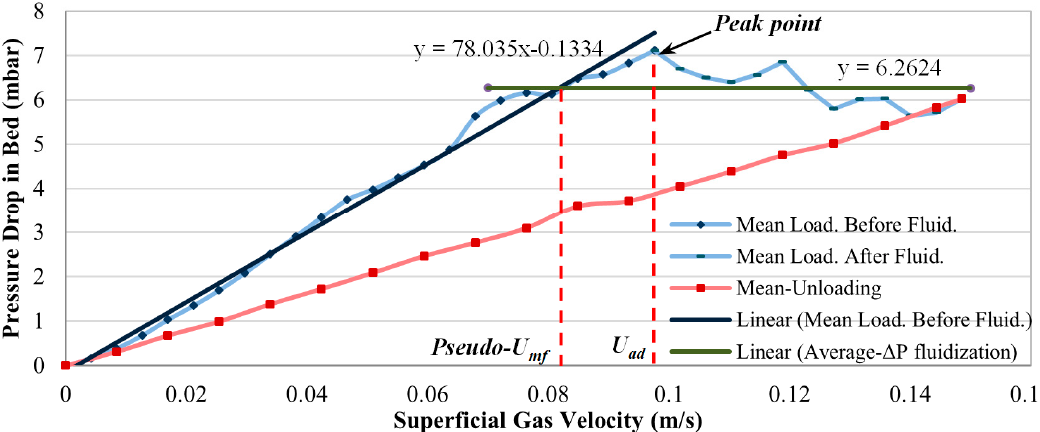
unloading of fine particle bed (CALCIT MVT-100). Processes 2019 , 7 , x FOR PEER REVIEW